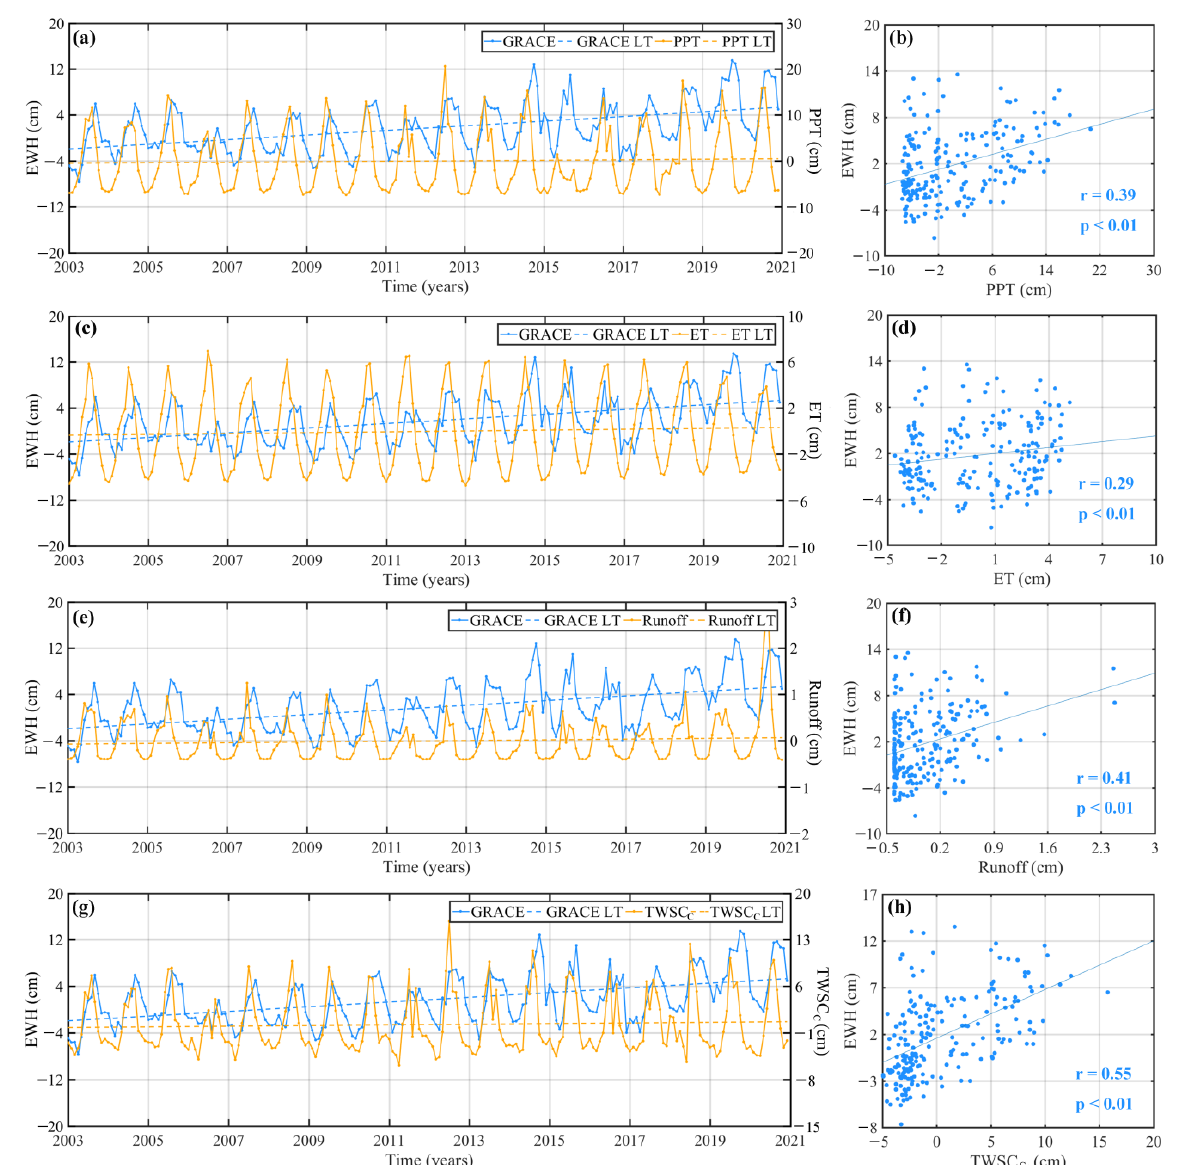
Figure 8. The relationships between monthly TWSC and ET, PPT, runoff, and TWSC C , respectively, in Sichuan during 2003~2020 . ( a ), ( c ), ( e ) and ( g ) show the time series and long-term trend changes of PPT, ET, runoff and TWSC C , respectively; ( b ), ( d ), ( f ) and ( h ) show the correlation coefficients between TWSC and PPT, ET, runoff, TWSC C , respectively. Table 5. The long-term change trend, acceleration, annual amplitude, and annual phase of TWSC and natural factors in Sichuan.